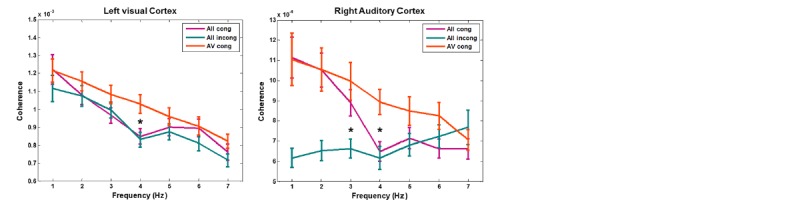
DOI:
http://dx.doi.org/10.7554/eLife.14521.014